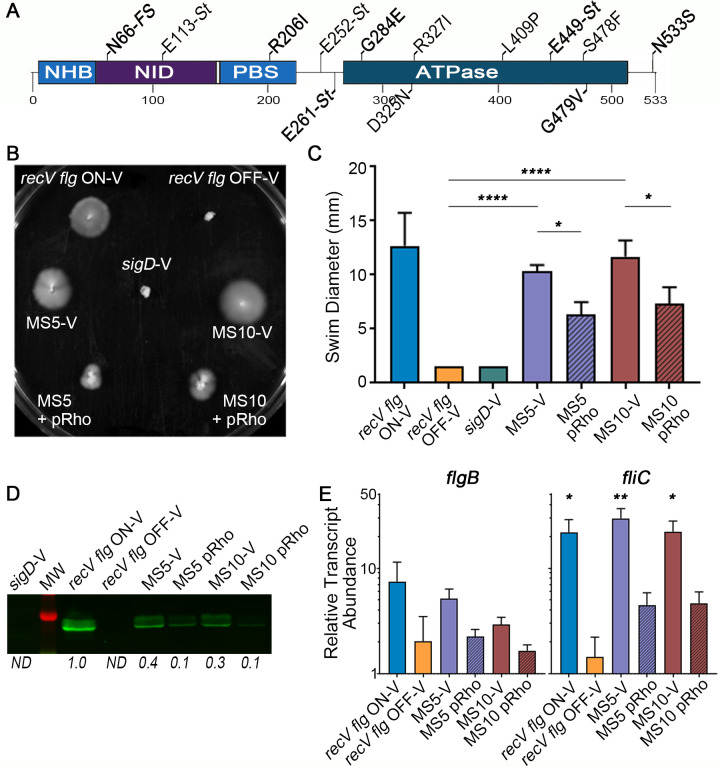
Rho is a negative regulator of flagellar motility.(A) Diagram of Rho factor domains and single nucleotide polymorphisms (SNPs) identified in the motile suppressors (MS). NHB–N-terminal helix bundle, NID–N-terminal insertion domain, PBS–primary binding site, FS–frameshift, St–stop codon. N66-FS results in a stop codon at residue 73. (B) Swimming motility in soft agar medium of motile suppressor 5 (MS5; N66-FS) and 10 (MS10; E113-St) expressing wild-type rho (pRho) or bearing vector at 48 hours. Controls included recV flg ON, recV flg OFF and non-motile sigD mutant carrying vector. (C) Quantification of swimming motility after 48 h of strains in (B). The means and standard deviation from 3 independent experiments are shown. ****p<0.0001, *p<0.05 by one-way ANOVA and Tukey’s post-test. (D) Immunoblot detection of FliC by strains in (B, C). Shown is a representative image of three independent experiments. Numbers represent quantification of band intensity expressed as the fold change compared to recV flg ON for the image shown. ND–non-detectable. (E) Relative transcript abundance of flgB and fliC measured by qRT-PCR. The means and standard deviation from 4 biological replicates are shown. **p<0.01, *p<0.05 by one-way ANOVA and Dunnett’s post-test compared to recV flg OFF.